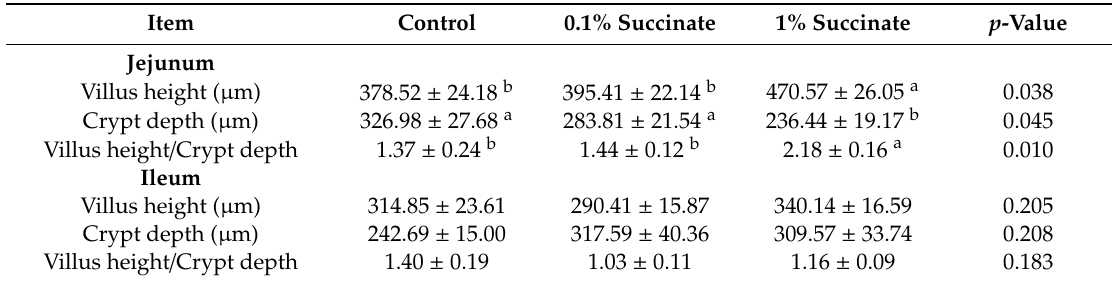
Table 4. Effect of diet sodium succinate supplementation on the intestinal morphology in growing pigs.